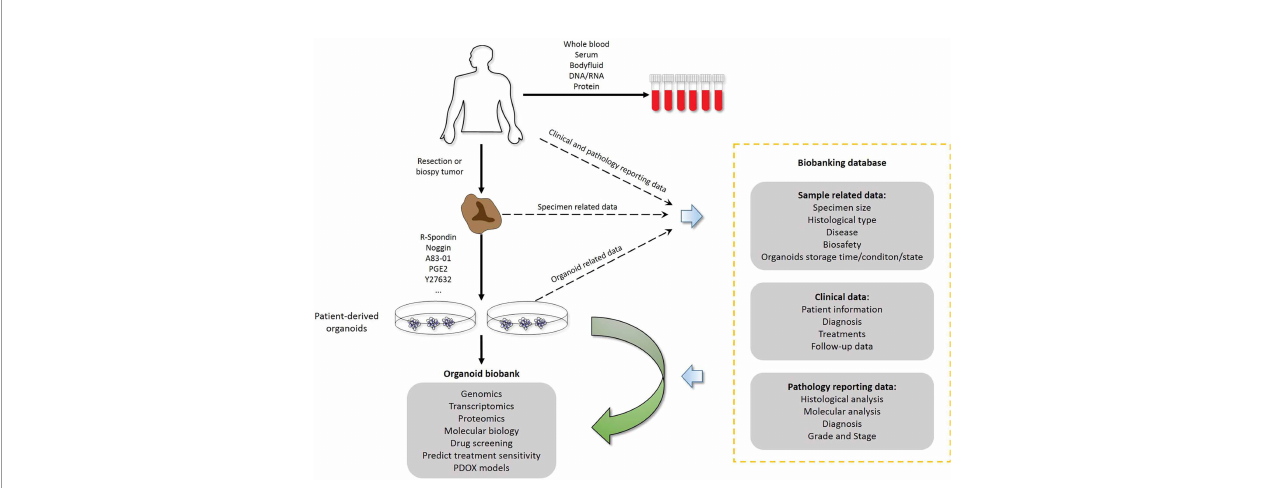
FIGURE 3 | Combination of living organoid biobank and databases improves cancer research and precision medicine. Patient-related data are available through the hospital information system and contain sensitive patient information that external researchers cannot access. Researchers who have obtained ethics committee approval can collect sample-related anonymous information from the biobank data management system, and obtain the organoid model and fresh frozen tissue from the biobanking infrastructure. Therefore, researchers can use organoid models for drug screening and testing chemotherapy response at the individual patient level. PDOX models, Patient-derived organoid xenograft